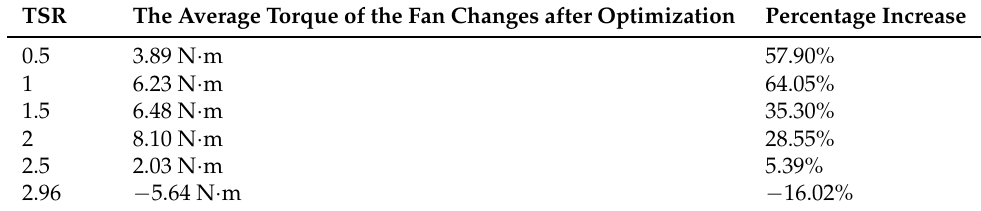
Table 6. Average torque variation of offshore wind turbine after optimization.